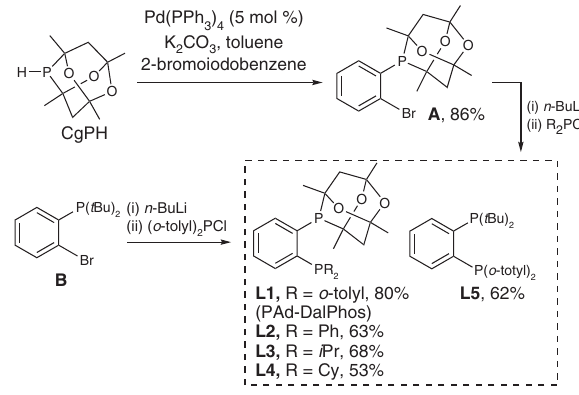
Figure 2 | Synthesis of the bisphosphine ligands L1–L5. L1–L4